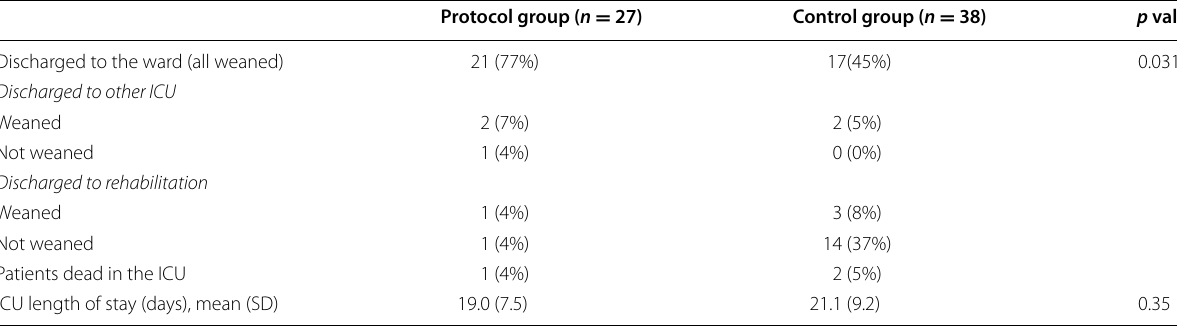
Table 2 Outcome of the study population